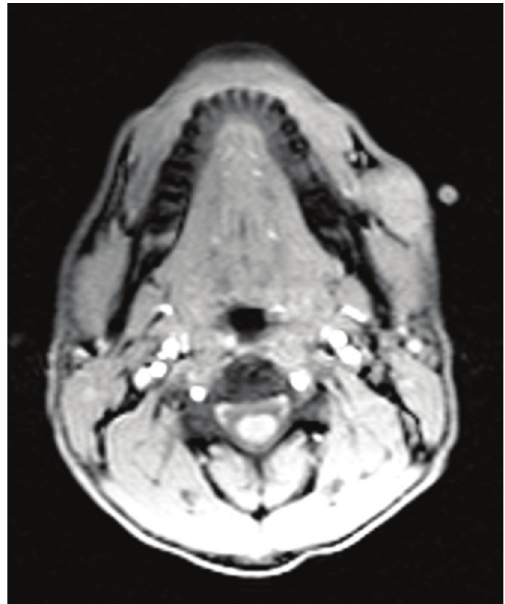
Figure 2: Axial view of a T2 magnetic resonance image at the level of the mandible showing a heterogeneous mass on the left side of the face with no evidence of deep invasion.